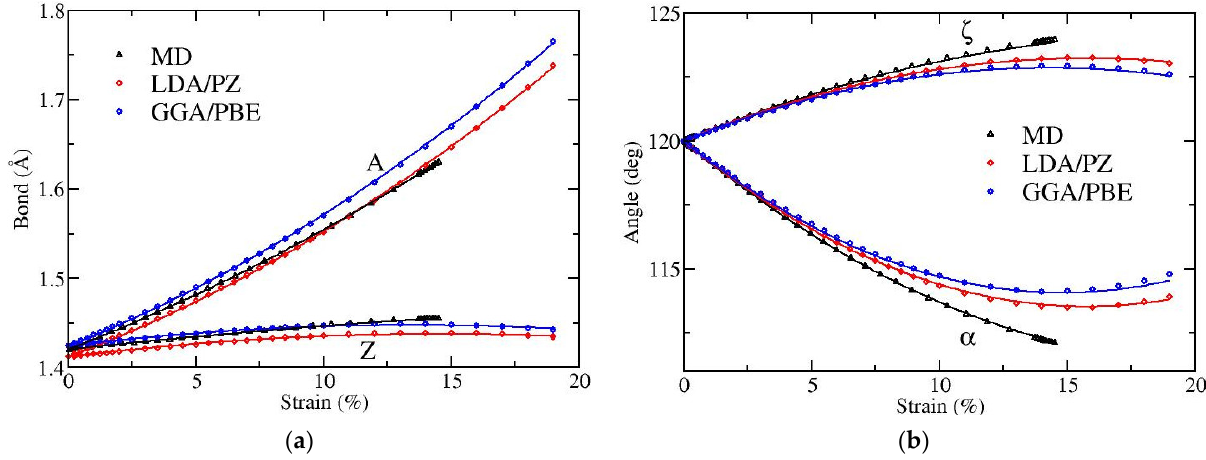
Figure 2. Strain dependence of ( a ) bond lengths and ( b ) bond angles, for uniaxial strain along the armchair direction of graphene. A and Z in ( a ) [α and ζ in ( b )] correspond to the different kinds of bonds [angles], as shown in Figure 1. Black points show results obtained by MD, while red and blue points show data obtained by DFT using LDA and GGA functionals, respectively. Lines represent fits with quadratic polynomials [see Equations (1) and (2)].